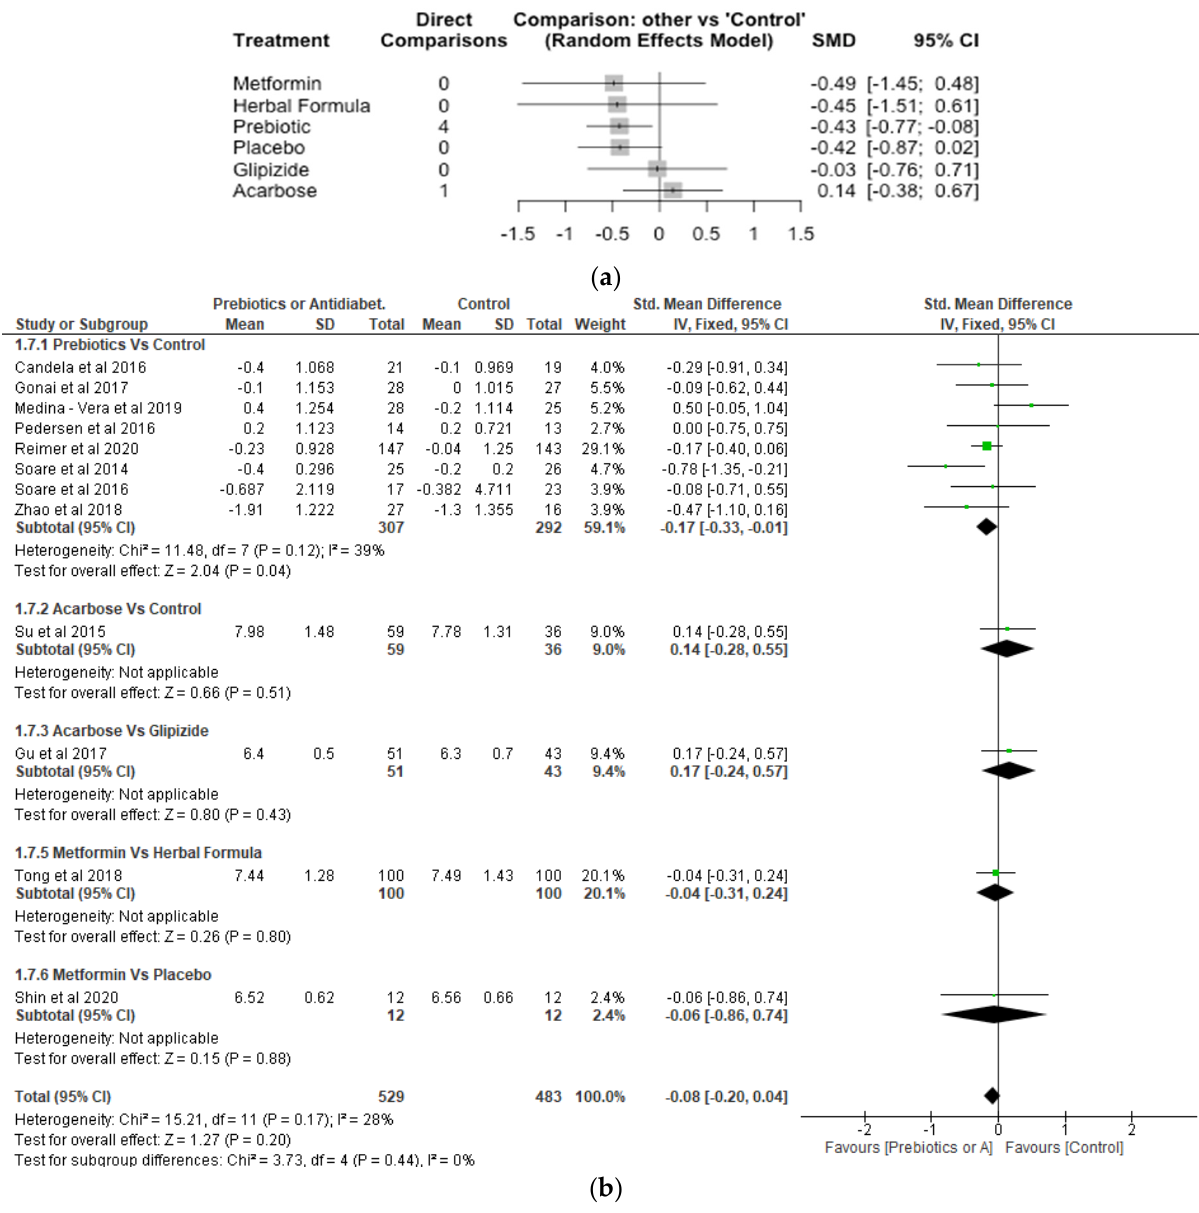
Figure 6. Network Meta-analysis ( a ) and Meta-analysis ( b ) of the effect of treatments versus control on glycated haemoglobin (HbA1c) [31,32,38–46,48]. Fasting Blood